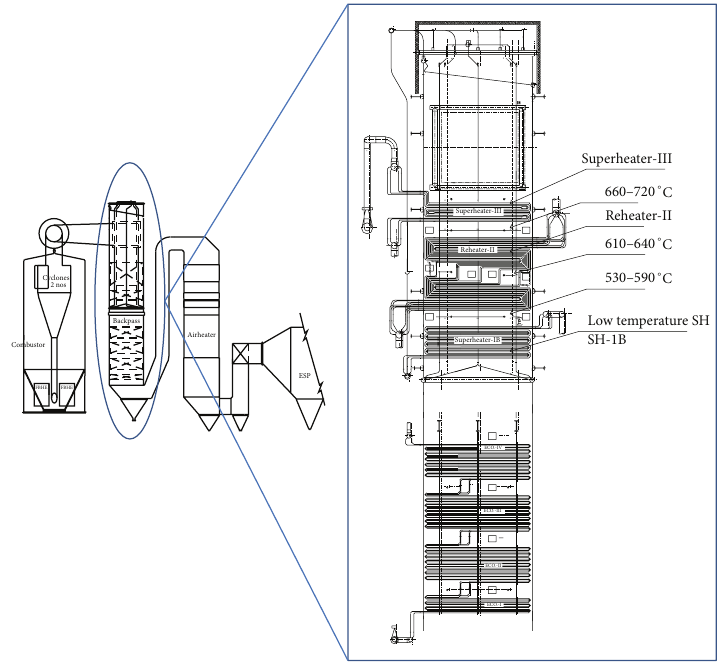
Figure 3: General arrangement of CFBC boiler and backpass.